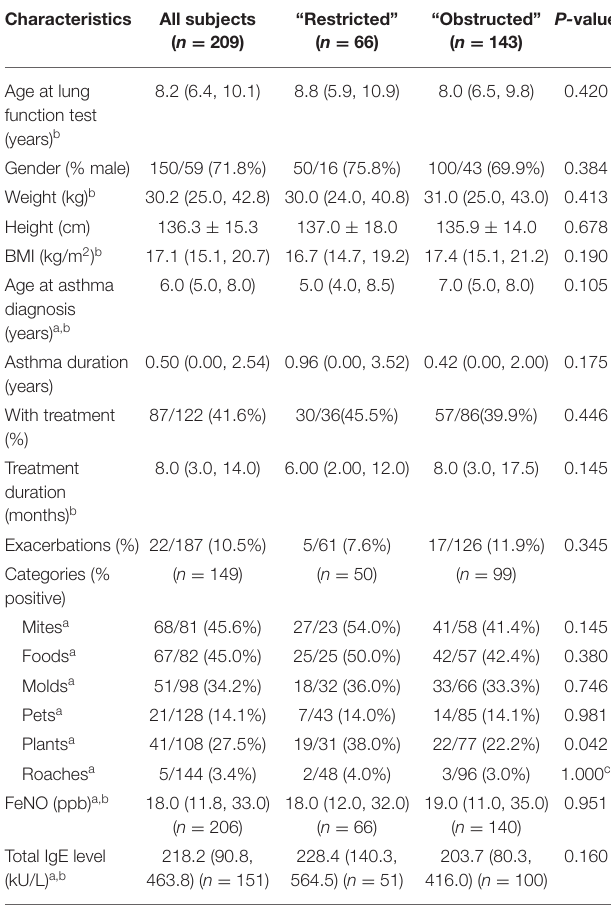
TABLE 1 | Demographic and clinical characteristics of the study